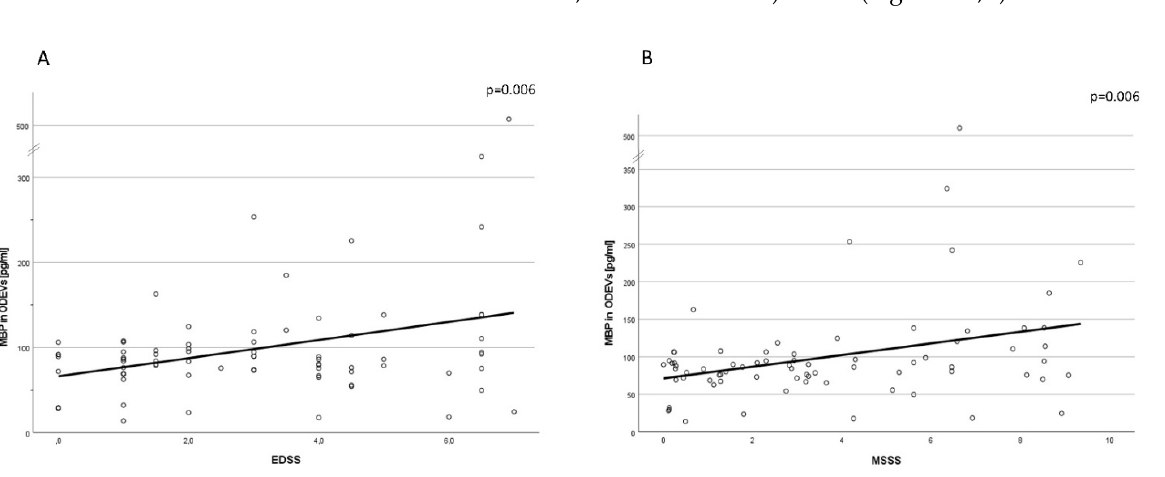
Figure 4. ( A ): Correlation between MBP in ODEVs and clinical scales . Bivariate Pearson’s correlation between MBP concentration in enriched ODEVs and EDSS. ( B ): Bivariate Pearson’s correlation between MBP concentration in enriched ODEVs and MSSS.